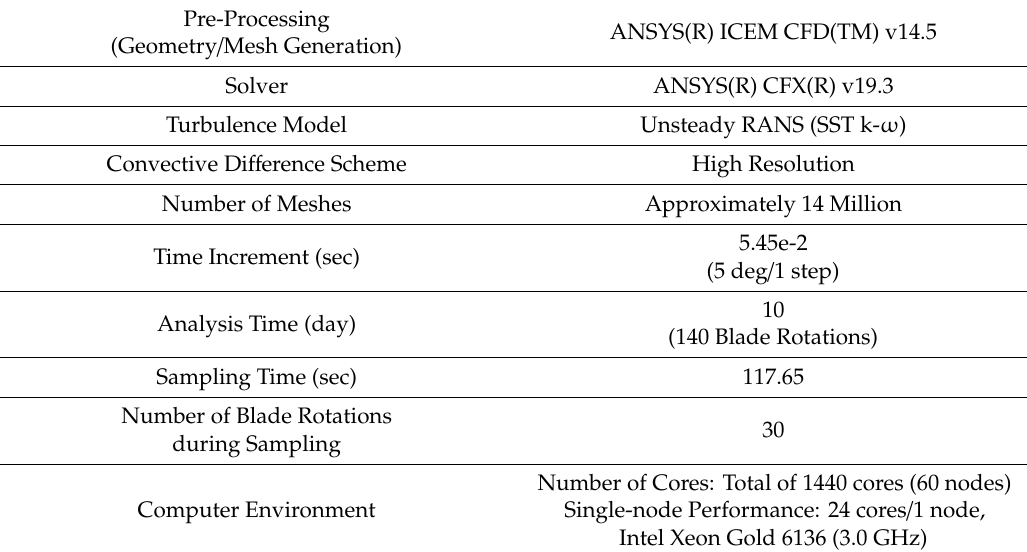
Figure 14. Computational domain and computational grid for a real wind turbine, using the fully resolved geometries combined with the unsteady RANS approach using ANSYS(R) CFX(R). Table 2. Simulation conditions for the real wind turbine.